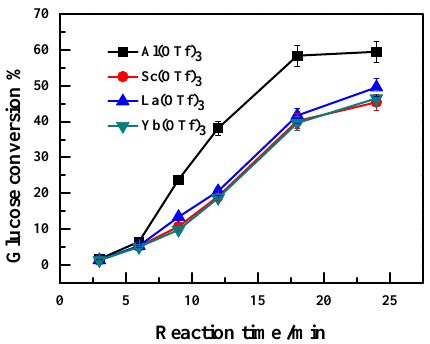
Figure 1. Effect of ionic radii of Lewis acidic metal salts on the conversion of glucose. Reaction conditions: reaction temperature of 160 °C, reaction time of 25 min, 0.1 g glucose in 1.5 g 25 mM Lewis acids aqueous solution, 3 g sec-butyl phenol.